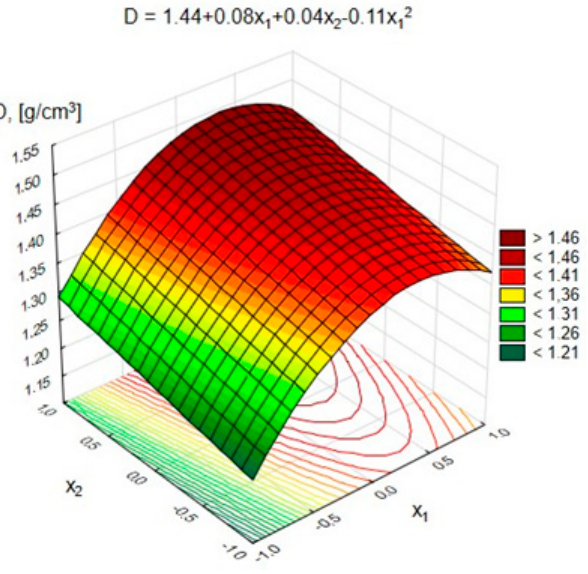
Figure 10. Changes in the volume density of the GLC depending on x 1 and x 2 .